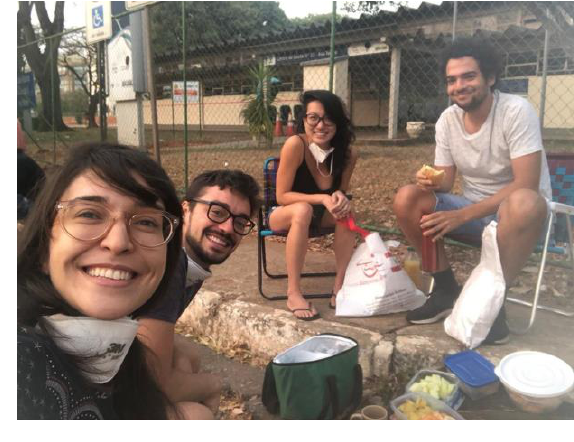
Figure 11. Waiting for vaccination. Photo: Roberta Saita, September